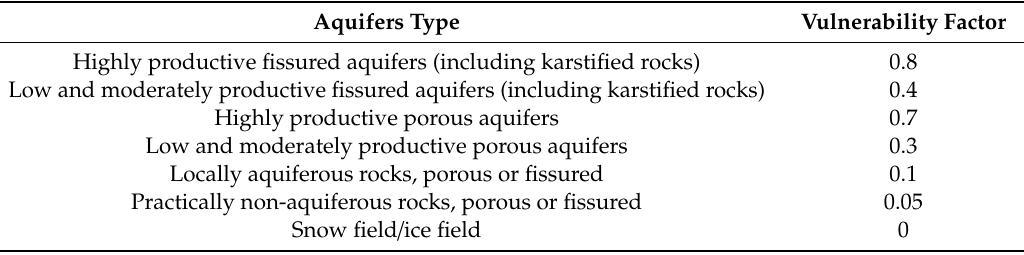
Figure 3. Vulnerability factor distribution at a spatial scale of the Piedmont region. Source: Nistor et al. (2019). Table 1. Aquifers productivity in the Piedmont region. Aquifers Type Vulnerability